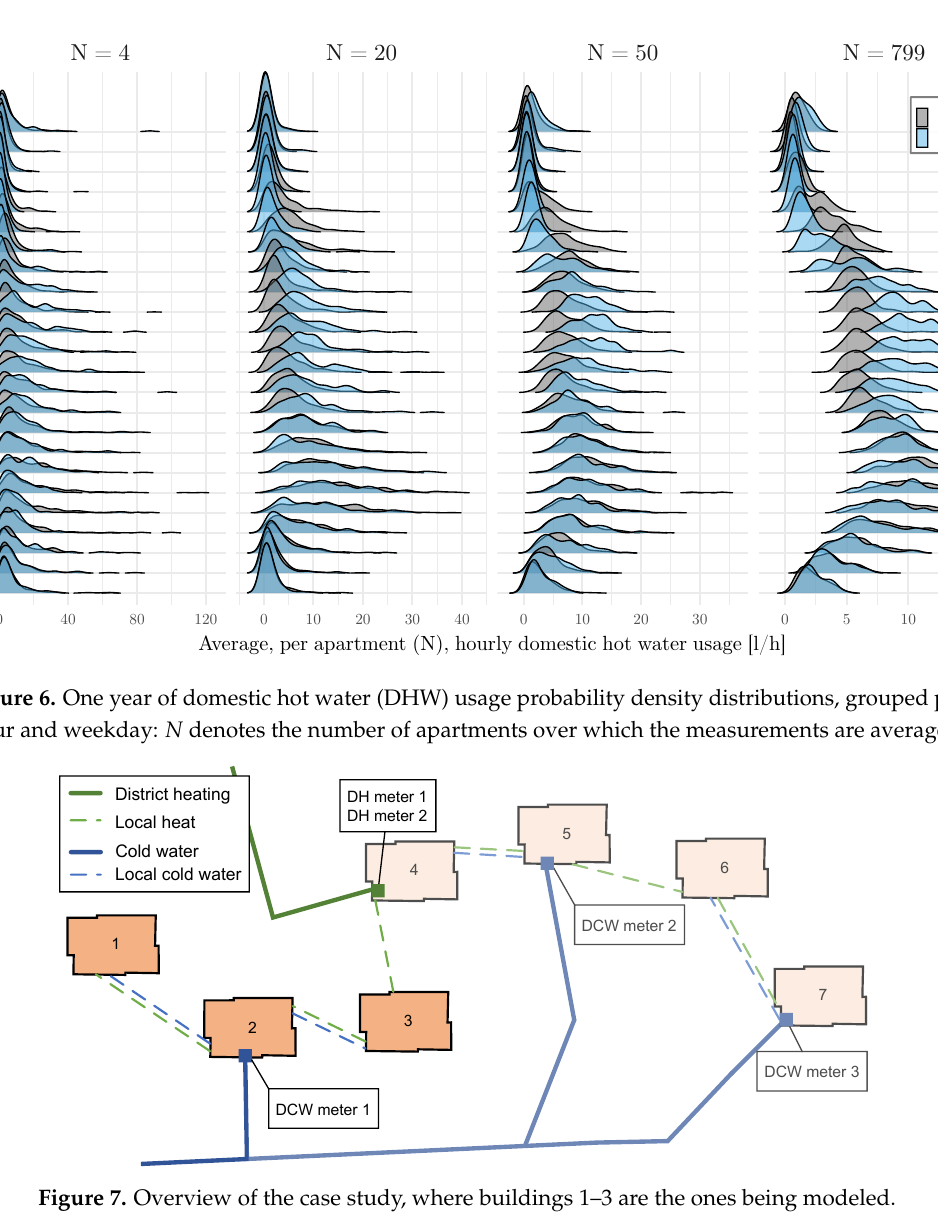
Figure 7. Overview of the case study, where buildings 1–3 are the ones being